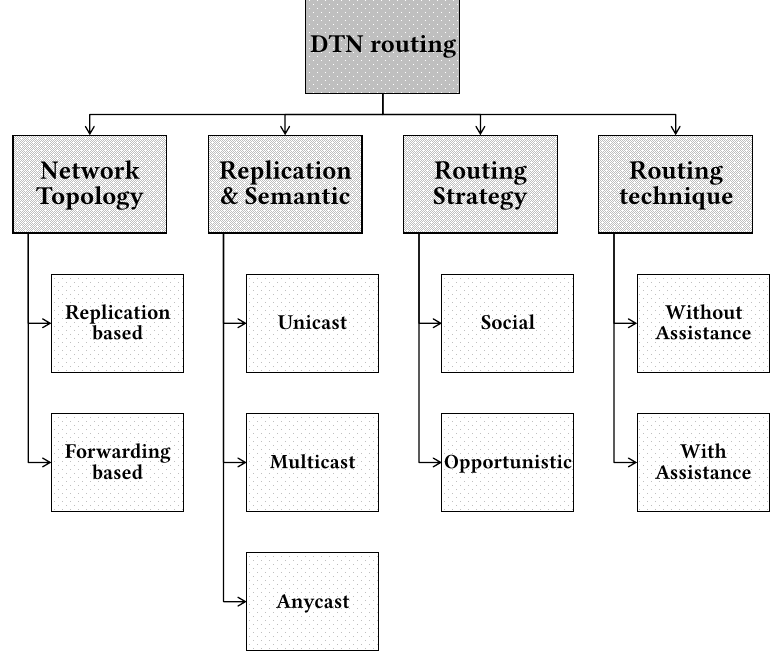
Figure 1. Classification of DTN routing